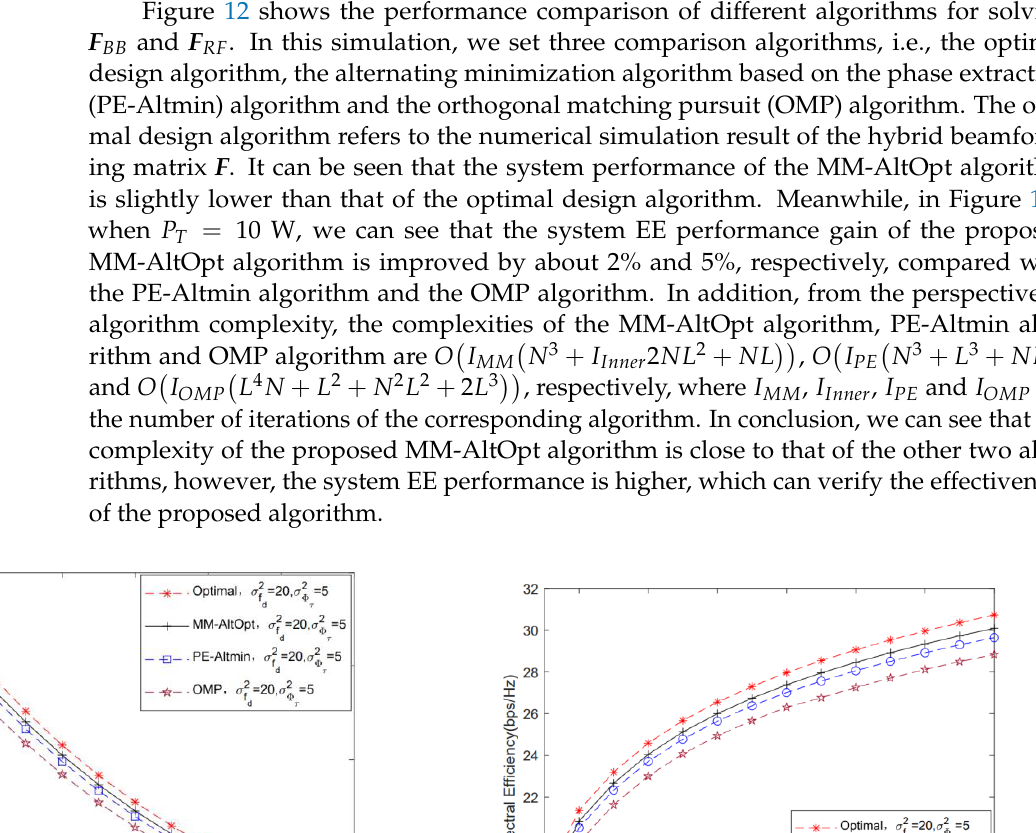
Figure 11. Change trajectory of system performance versus different U s . ( a ) Change trajectory of system EE versus different U s ; ( b ) change trajectory of system SE versus different U s .